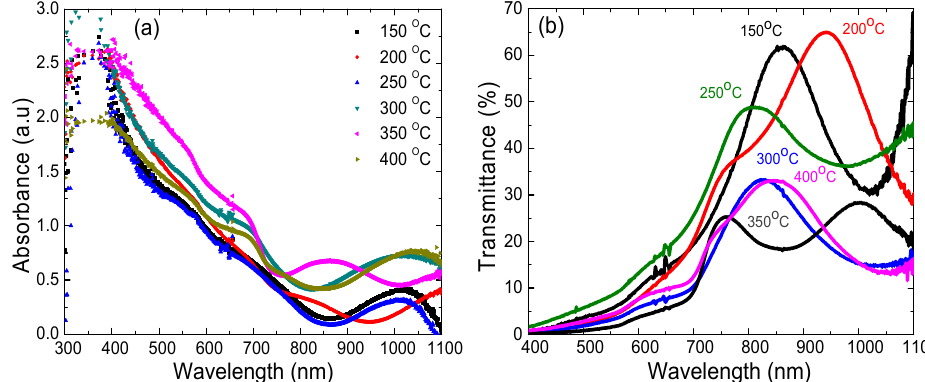
Figure 3 . ( a ) Absorbance vs. wavelength and ( b ) transmittance vs. wavelength for CdSe thin films deposited on ITO/glass substrates at different temperatures.